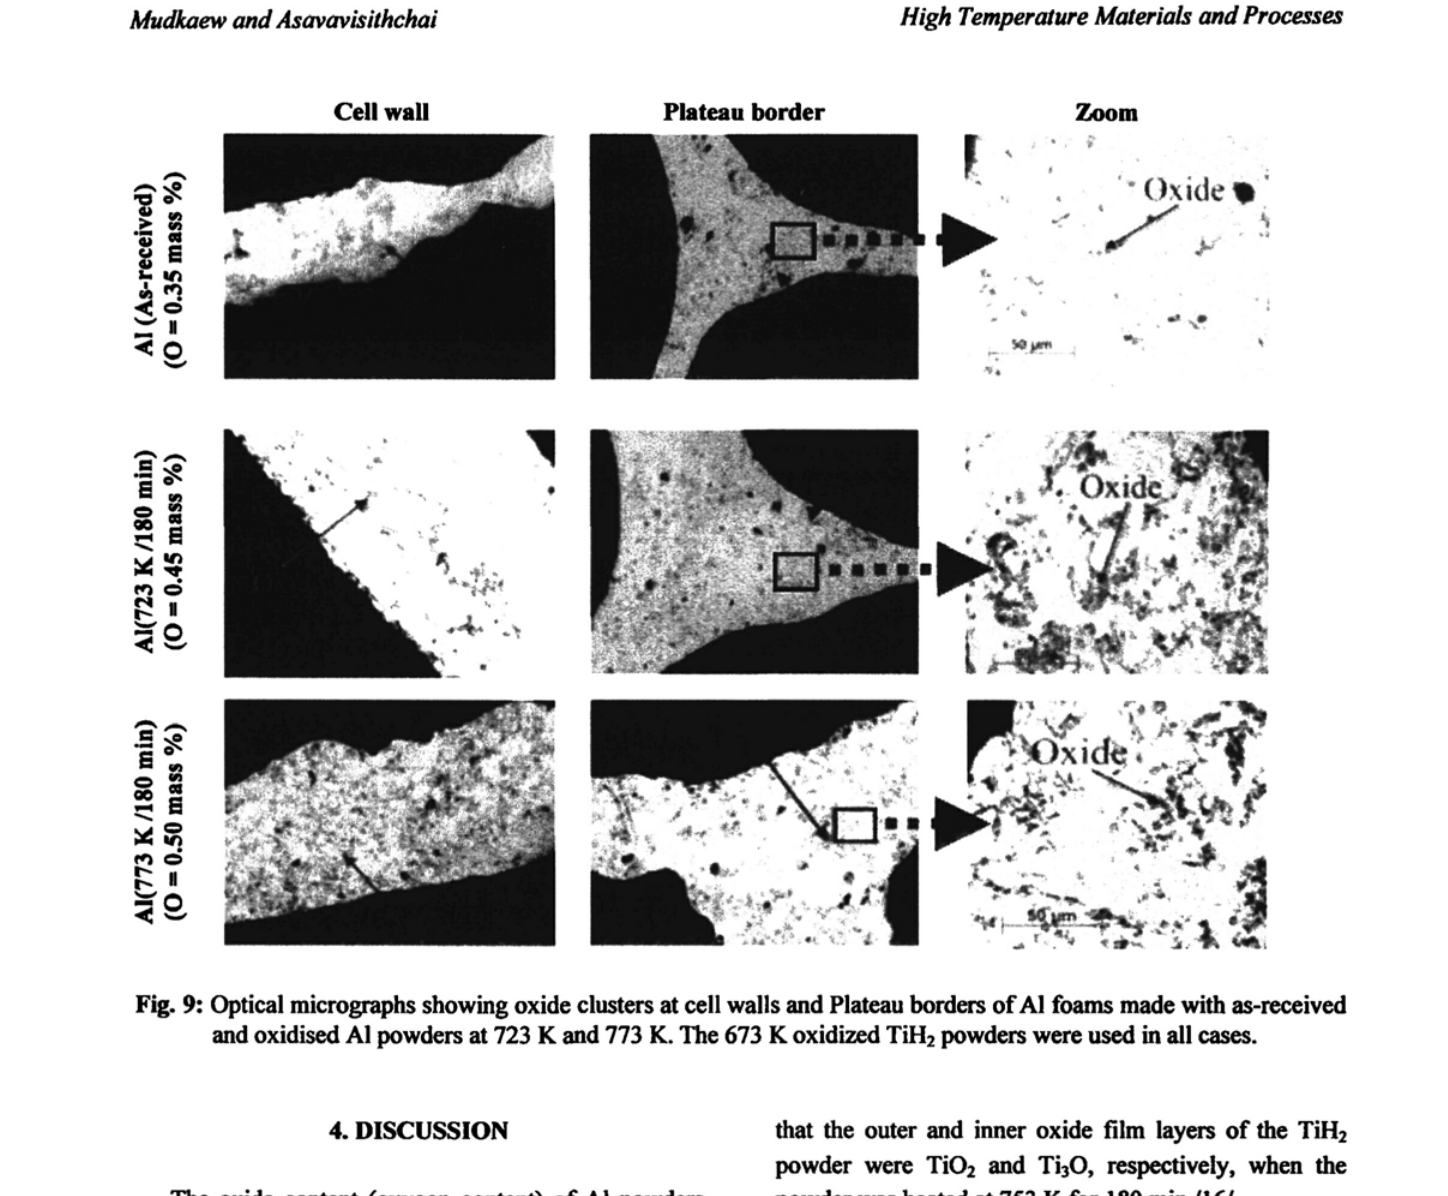
powders were used in all 7